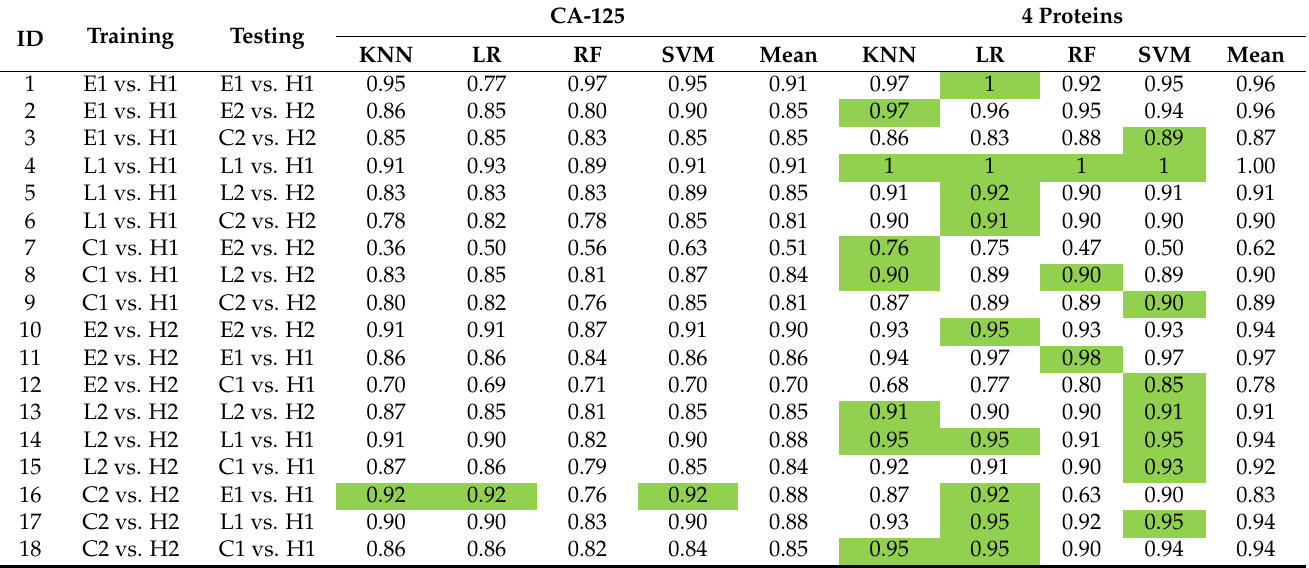
Table 2. Comparison of accuracy between CA-125 alone and all four proteins (CA-125, MIF, OPN, and PROL) when using the four classification methods, K-Nearest Neighbor (KNN), Logistic Regression (LR), Random Forest (RF), and Support Vector Machine (SVM), in various experiments. In each experiment, “training” column and “testing” column list the subsets used for training and testing the classification models. In these columns, the letters “C”, “E”, “L”, and “H” denote serum samples from ovarian patients, from patients in early stage, in late stage of ovarian cancer, and healthy samples, respectively. The suffix, e.g., 1 or 2, indicates that samples are from cohort set 1 and cohort set 2. The accuracy measures the ability to correctly label the testing samples and is defined as the ratio of the number of samples correctly classified to the total number of samples. We highlighted the cell(s) with best accuracy in each experiment. In general, using logistic regression and all four proteins yield the best results on most occasions.